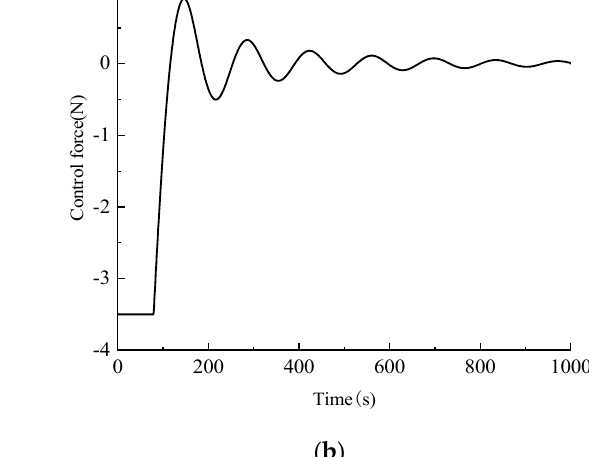
Figure 4. Simulation curves of a PID controller. ( a ) Depth curves. ( b ) Control force curves.